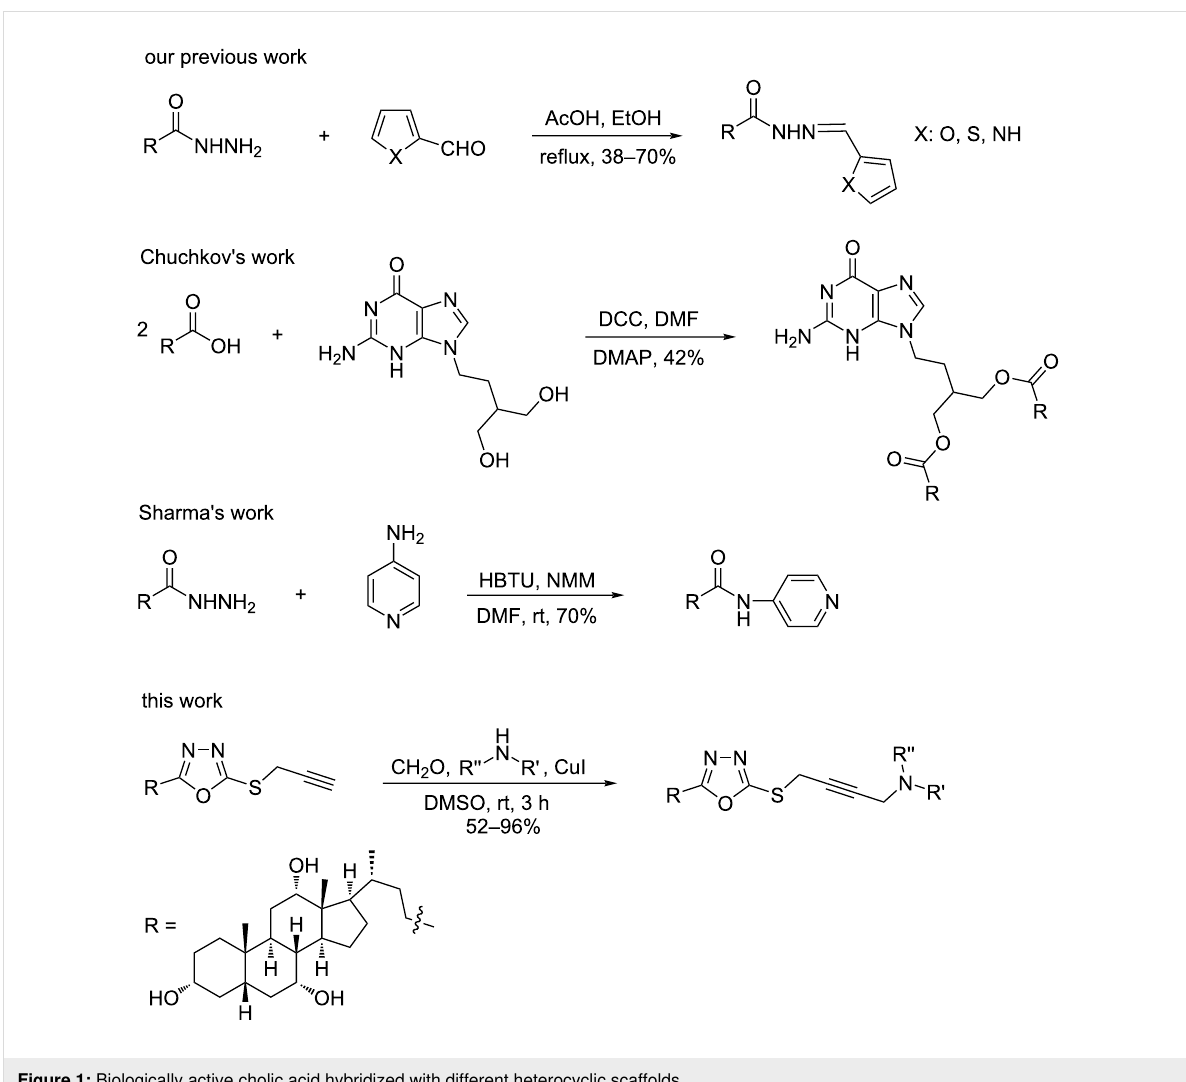
Figure 1: Biologically active cholic acid hybridized with different heterocyclic